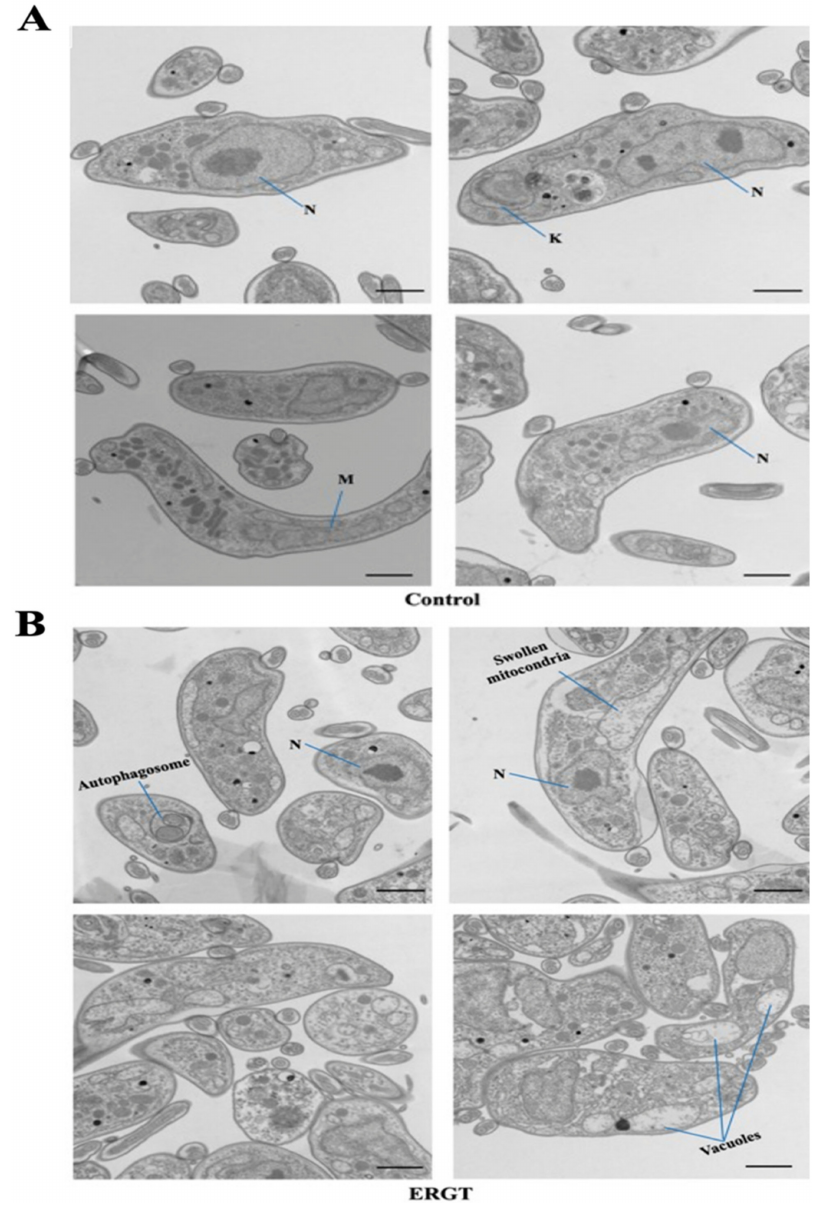
Figure 4. Electron microscopy of the ERGT-treated T. brucei. T. brucei BF cells were incubated with ERGT at 5 × EC 50 for 4 h. Cells were harvested, treated with fixative solution, and prepared for electron microscopy as described in the materials and methods. Untreated control cells were run in parallel ( A ). Images from cells treated with ERGT are shown in ( B ). N and K represent nucleus and kinetoplast. M represents mitochondria. Presence of autophagosome, swollen mitochondria, and large vacuoles found in treated cells are indicated. Two individual biological replicates were used for EM and multiple sections from each sample were examined. Scale bars represent 1 µ